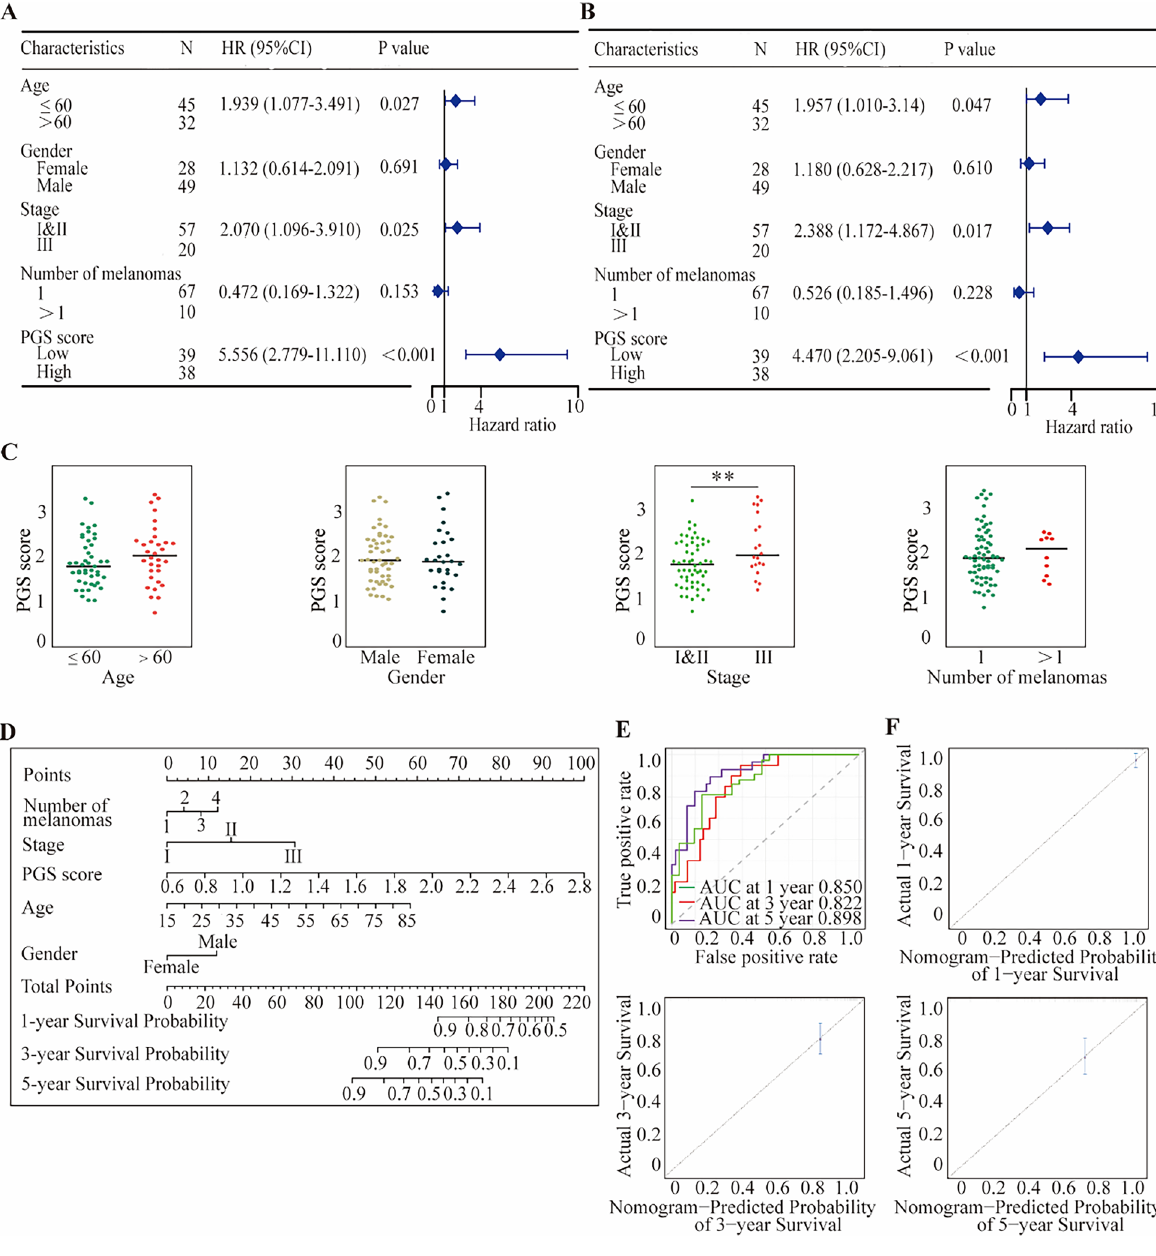
Figure 3. PGS scores are associated with the melanoma prognostic index in the GSE54467 samples. The PGS was found to be an independent risk factor for melanoma according to both univariate ( A ) and multivariate ( B ) Cox analysis. ( C ) Interrelationships between the PGS score and clinicopathological characteristics of the melanoma study patients. ( D ) Nomogram based on the PGS scores and clinicopathological characteristics. ( E ) Time-dependent ROC curves at 1, 3 and 5 years. ( F ) Calibration plot of the comparison between the nomogram-predicted and actual 1, 3 and 5-year OS periods. Statistical analysis: ** p < 0.01. This figure was created using R software version 4.0.3 (https:// www.r- proje ct.